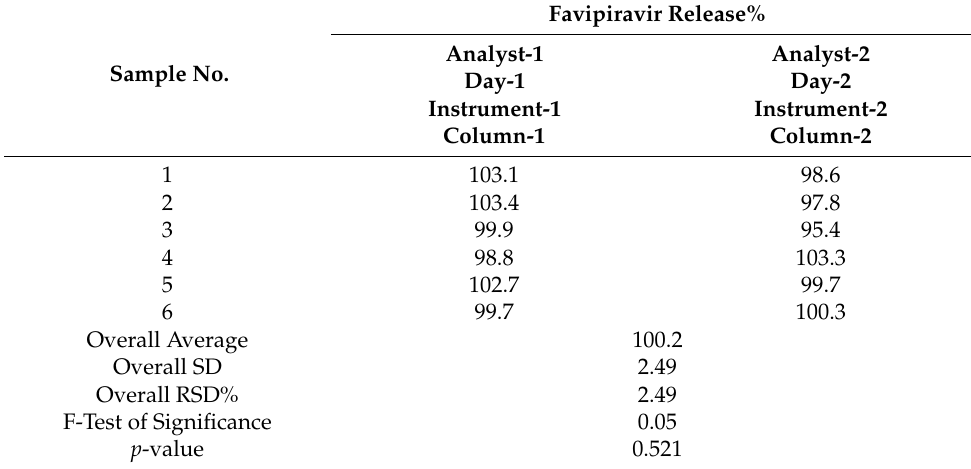
Table 7. Results of intermediate